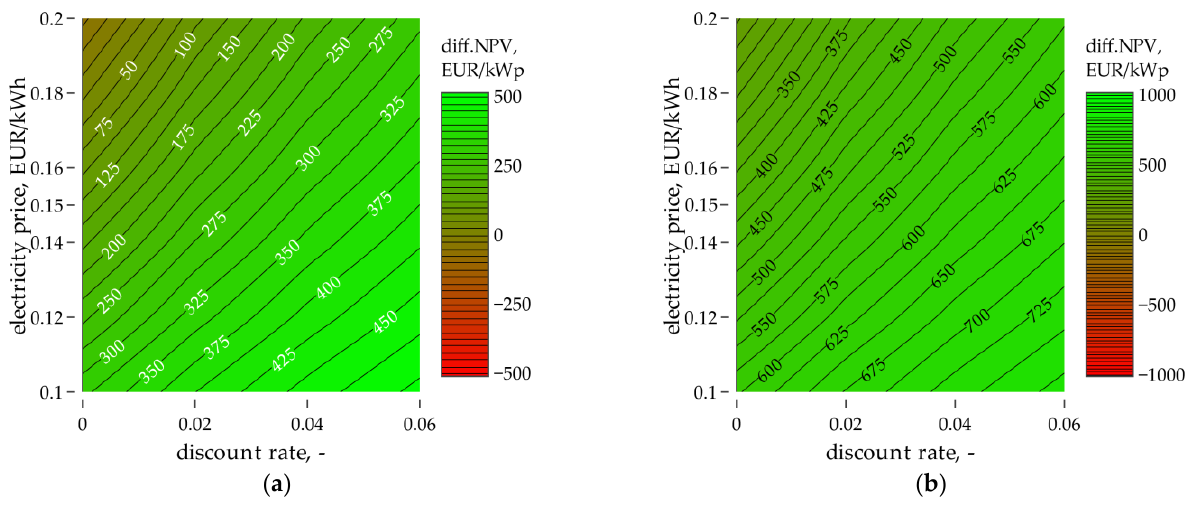
Figure 22. Difference of Net Present Value (diff.NPV) Leki-Bydgoszcz as a function of electricity price and discount rate value: ( a ) excluding subsidies; ( b ) including subsidies. ElP = 0.15 EUR/kWh is actual electricity price in Poland.